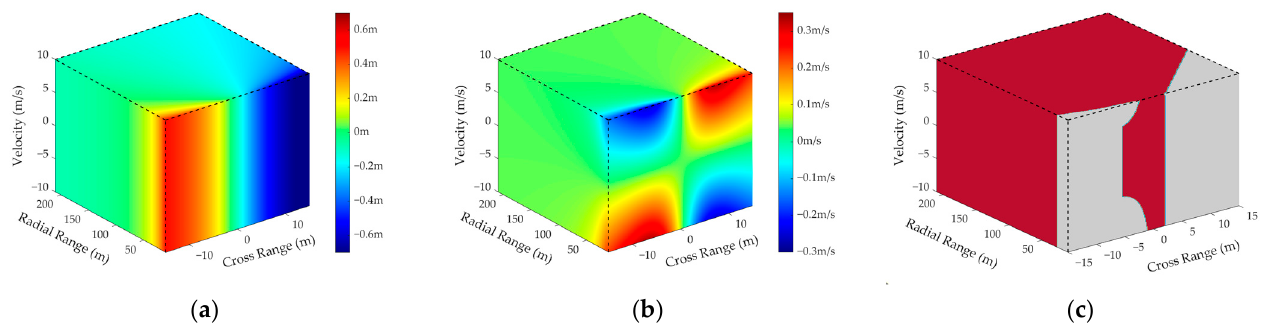
Figure 7. The simulation results of Test 2. ( a , b ) display the range and velocity deviations. ( c ) represents radar detection scenario, including effective region (red) and ineffective region (gray).